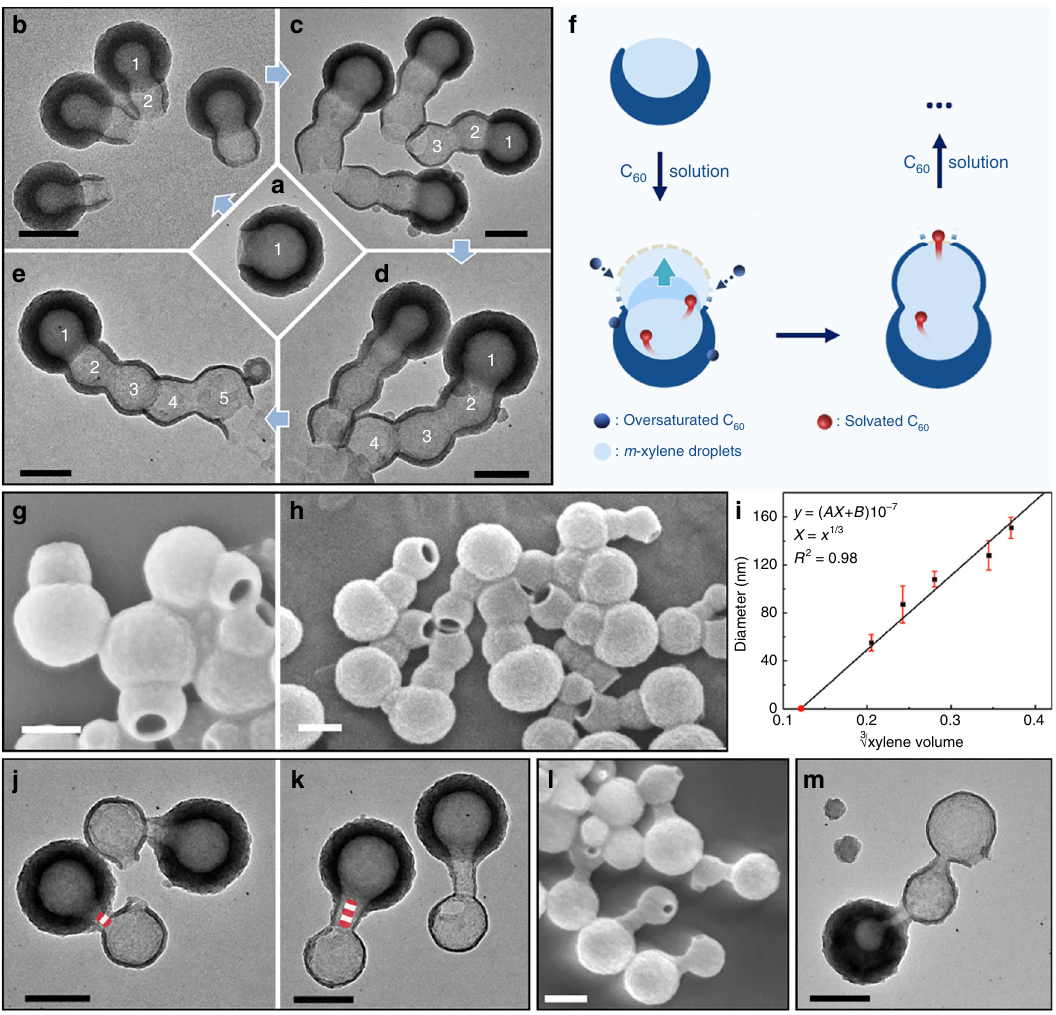
Fig. 3 Addition of nodes and junctions to nanobowls and bottles. TEM images of a typical C 60 nanobowl, and b – e nanocucurbits with 2 – 5 nodes, respectively. f Schematics illustrating the formation of the node. g , h SEM images of nanocucurbits with two and three nodes. i Graph showing the linear relationship between the cavity diameter and the cubic root of the xylene volume. j , k TEM images of long-neck cucurbits with different neck length. l SEM image of long-neck cucurbits with neck length of 95 nm. m Addition of a node on long-neck cucurbits. Scale bars are 200